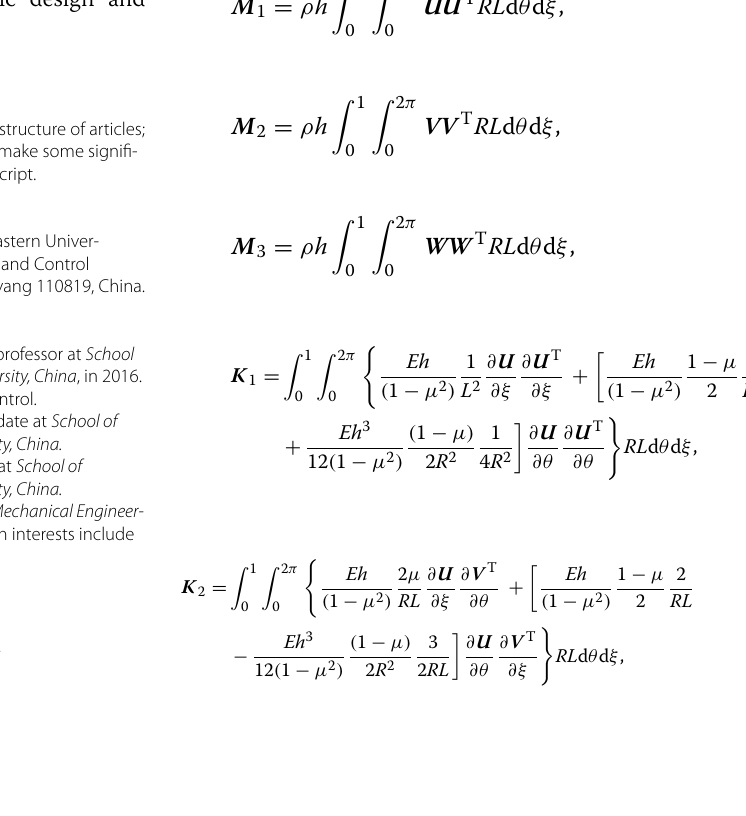
broken. From the failure modes of pressure pipe, the long crack may be caused by the low-frequency vibration, which has a low axial half-wave number and a high circumferential wave number, and the partial hole may be caused by high-frequency vibra- tion, which has a high axial half-wave number and a high circumferential wave number. Knowing these facts is important for pipe dynamic design and avoiding resonance points.